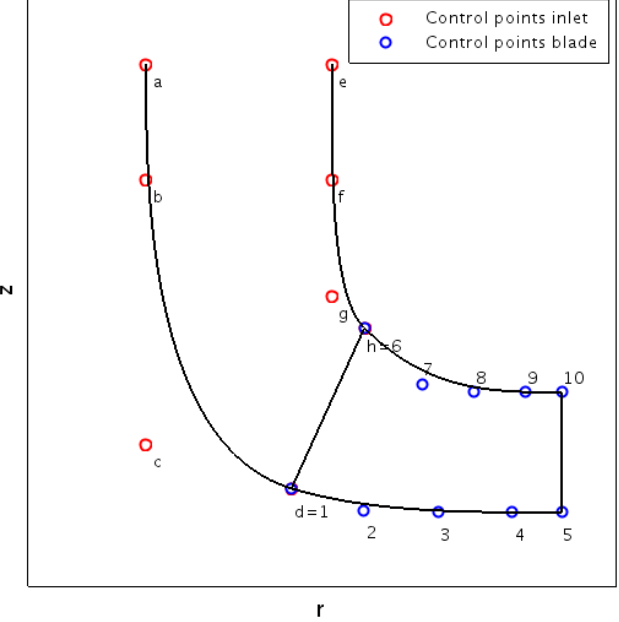
Figure 4. Control points for the meridional channel.